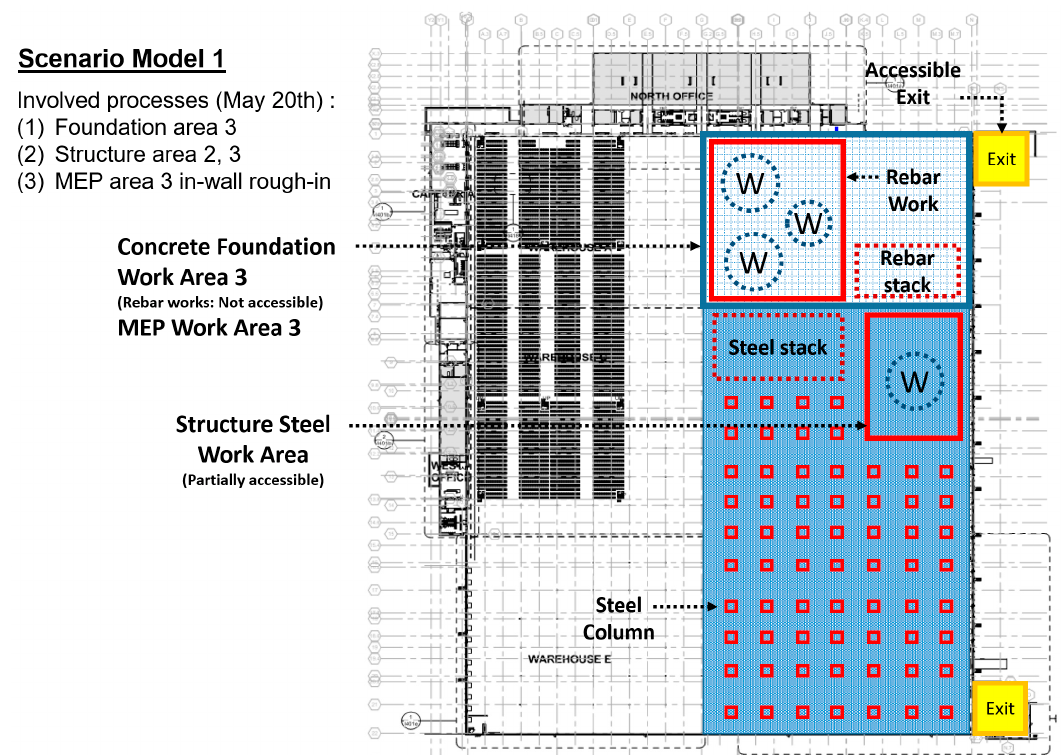
Figure 6. Scenario Model 1: Work status and site conditions.